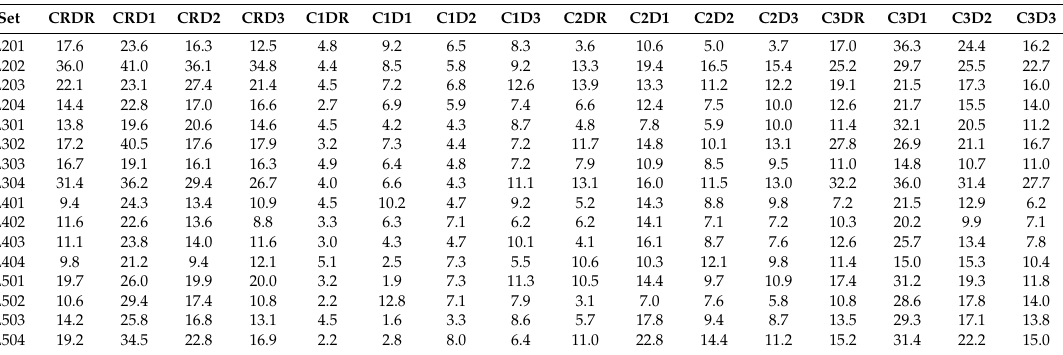
Table 6. Mean IGD values of 16 pairs.